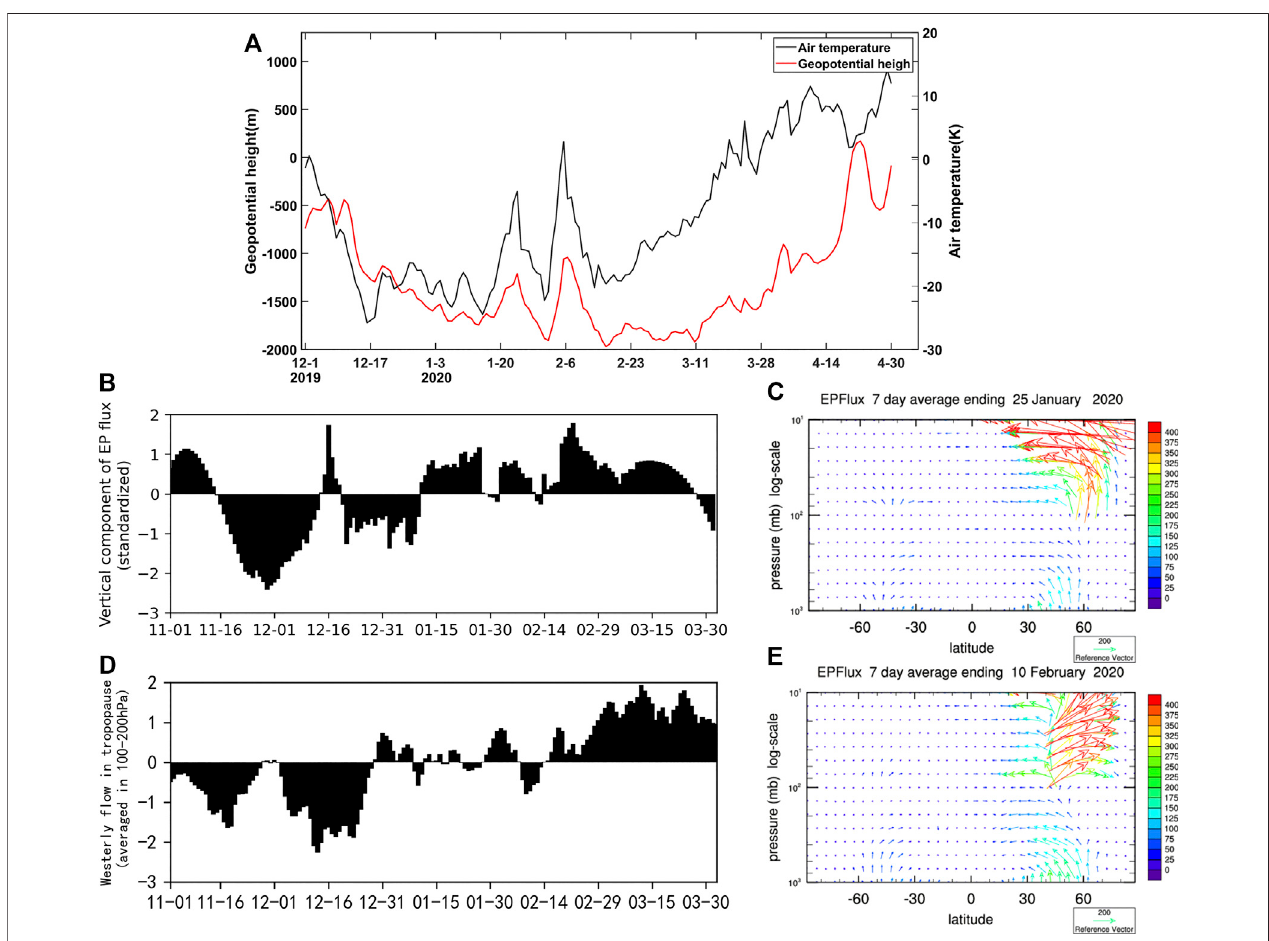
FIGURE2|(A) The difference inthezonal-average at 20 hPatemperature andgeopotentialheight at90 ° Nand 60 ° N. (B) Meandailyverticalcomponent ofthe1 – 3 zonalwaves ’ EP fl uxnorthof60 ° Nat10 – 200 hPa(standardized). (C) Globalverticalpro fi leoftheEP fl uxforJanuary19 – January25,2020. (D) Meandailywesterly fl owat the tropopause between 100 and 200 hPa (standardized). (E) Global vertical pro fi le of the EP fl ux for February 14 – February 20, 2020.